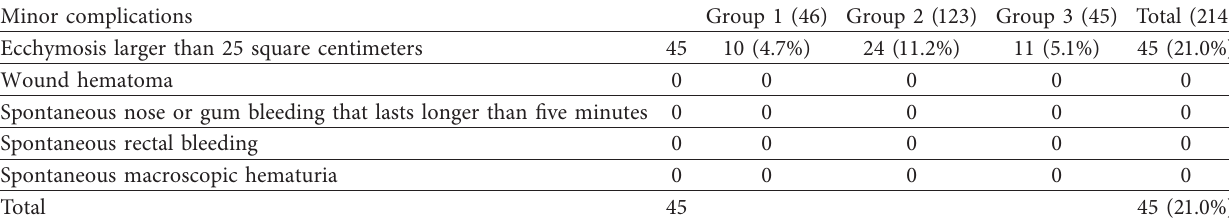
Table 2: Distribution of minor